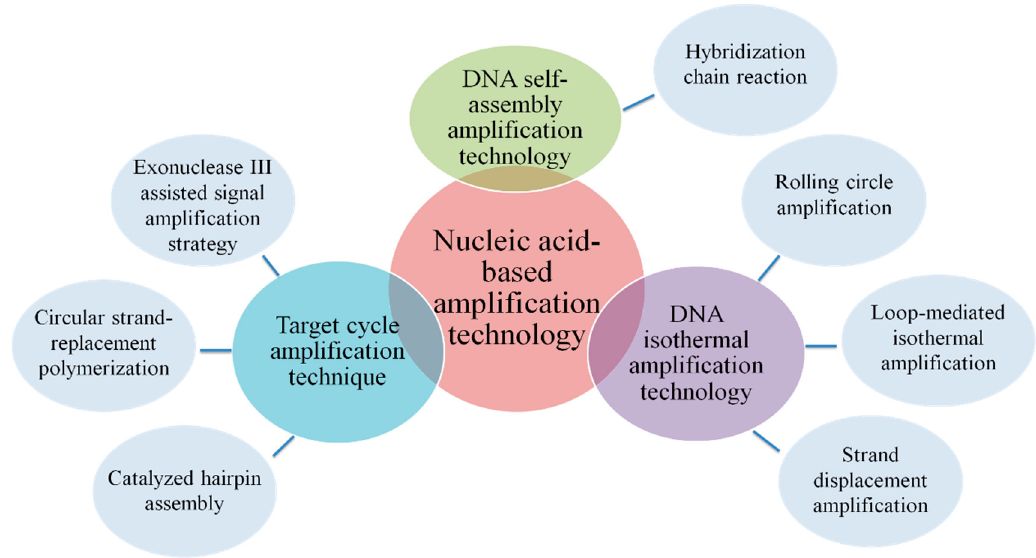
Figure 5. Classification of nucleic acid-based amplification technologies.